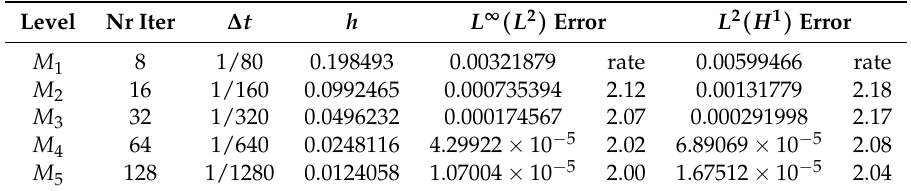
Table 2. L ∞ ( L 2 ) and L 2 ( H 1 ) errors and rates for the Leray-deconvolution model with N = 1. The final time is T = 0.1. The predicted rate order is 2.